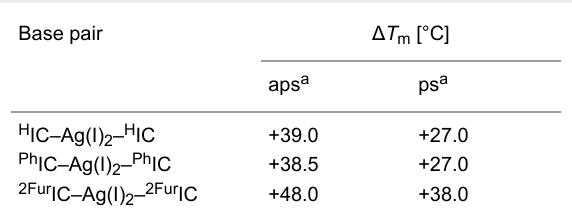
Table 3: Increase in melting temperature Δ T m of a representative DNA duplex bearing one X IC–Ag(I) 2 – X IC base pair (X = H, phenyl, 2-furyl)